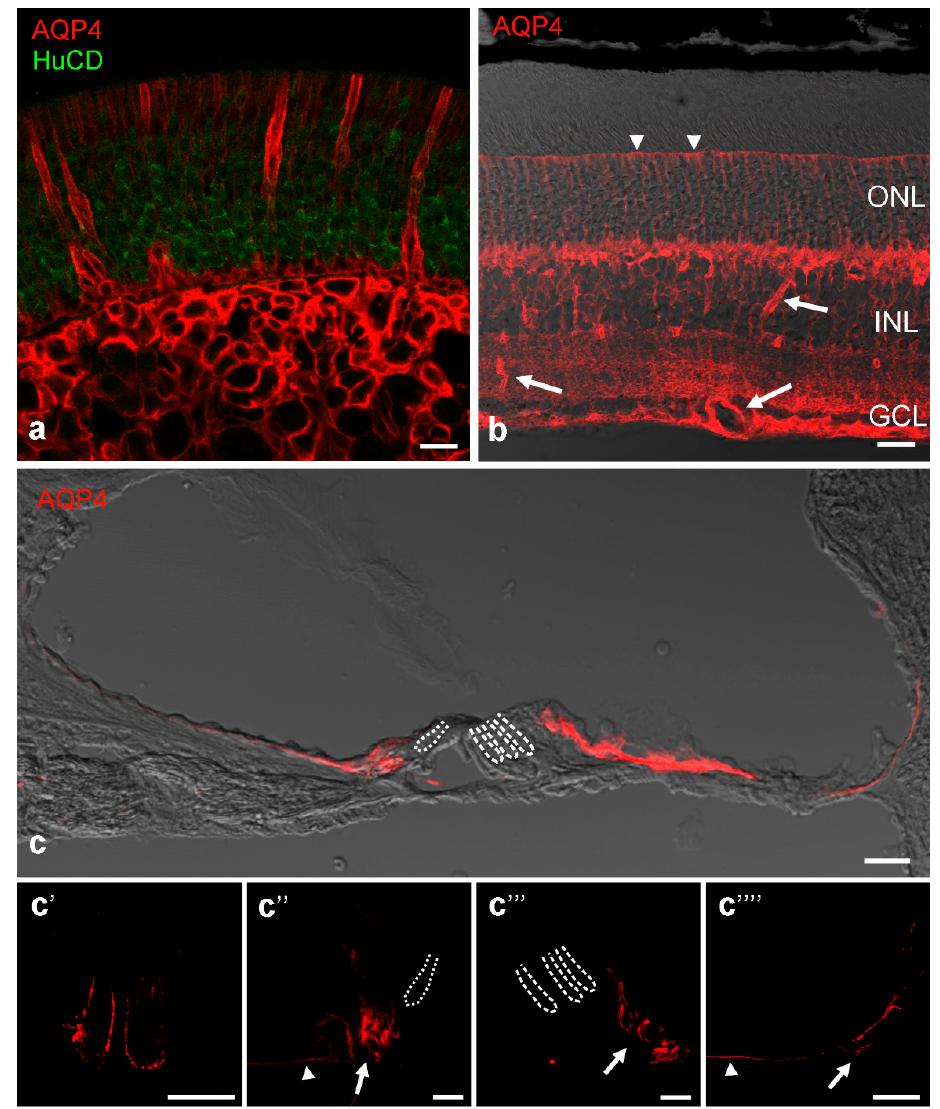
Figure 2. AQP4 immunocytochemical stains ( red ) in rodent sensory organs. ( a ) Rat olfactory region shows supporting epithelal cells and cells of Bowman’s glands positively stained. Receptor cells labelled by antibodies against the RNA-binding proteins HuC/D as a neuronal marker ( green ) are negative for AQP4; ( b ) AQP4 in the mouse retina is especially strong around blood vessels (arrows) but immunoreactivity is also present along the Müller cell processes and even at the outer limiting membrane (arrow heads). ONL: outer nuclear layer, INL: inner nuclear layer, GCL: ganglion cell layer; ( c ) AQP4 immunolabeling in the rat cochlear duct: In the medial part of the cochlear duct AQP4 was localized in the inner sulcus cells, and in the lateral part of the cochlear duct in Hensen’s cells and Claudius cells. The supporting cells of the organ of Corti were devoid of labeling for AQP4. The interdental cells and outer sulcus cells were out of focal plane. In c ′ – c ′′′′ detailed confocal images of the subcellular AQP4 expression in the rat cochlear duct are shown: ( c ′ ) In the medial part of the cochlear duct AQP4 is localized in the basolateral membranes of the interdental cells; ( c ′′ ) the basal membrane domains of the inner sulcus cells (arrow head), and the basolateral membrane domains of the inner sulcus cells directly adjacent the organ of Corti (arrow); ( c ′′′ ) In the lateral part of the cochlear duct AQP4 is localized in the basolateral membrane domains of Hensen’s cells (arrow); and ( c ′′′′ ) the basal membranes of Claudius cells (arrow head). The outer sulcus cells with their root process show AQP4 expression in the basolateral membrane domains (arrow). Dotted lines represent the localization of inner hair cells, dashed lines mark outer hair cells. Scale bars represent 20 µm in all images.